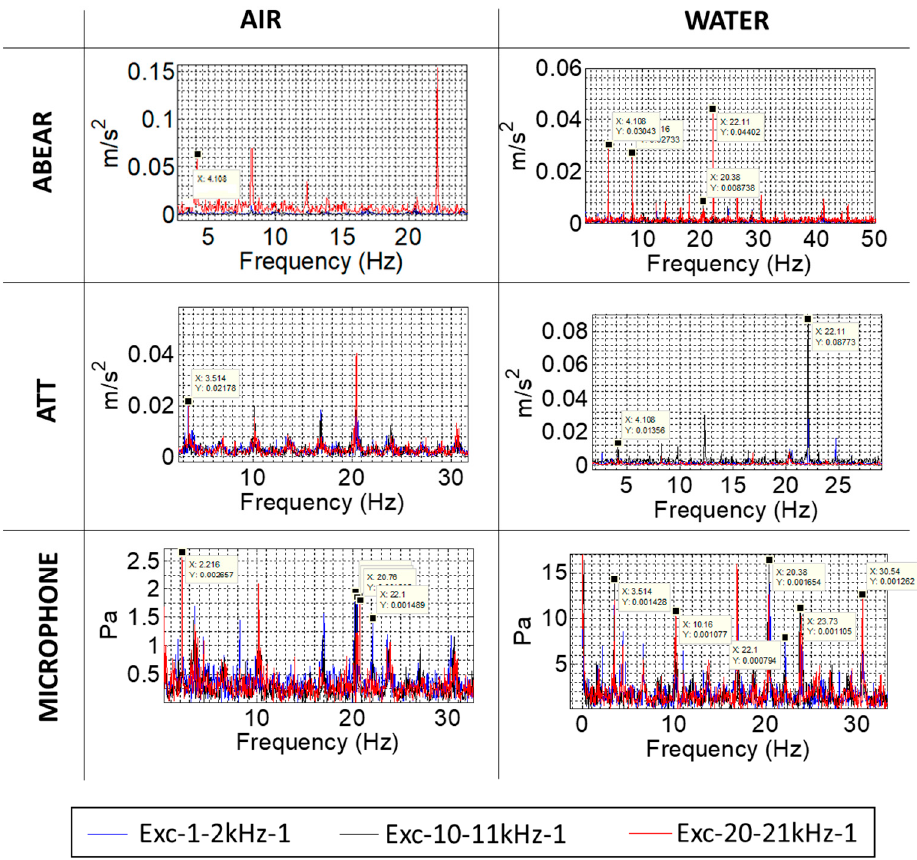
Figure 10. Amplitude demodulation for the sensors on the stationary frame and the excitation with one modulating frequency. Rotating case ( f f = 4.1 Hz).